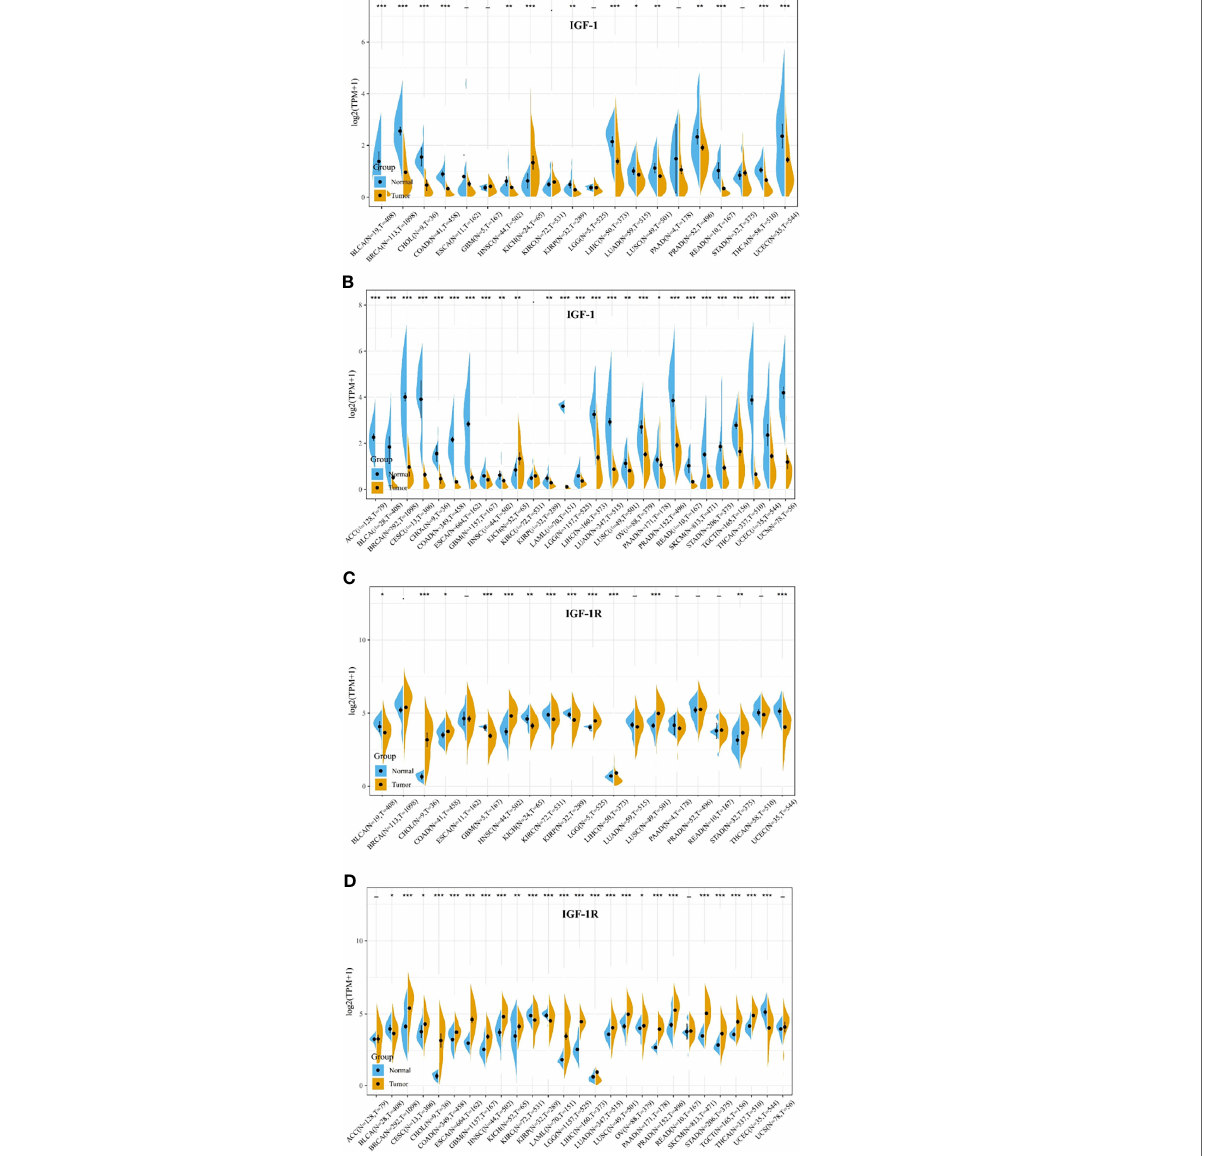
cells, CD8+ cells, dendritic cells, macrophages, and neutrophils. The correlation between the expression of IGF-1/IGF-1R and the immune in fi ltration levels across diverse cancer types is derived from TIMER. As for IGF-1, three of the most signi fi cant